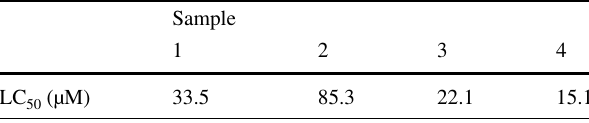
Table 1 Toxicity of compounds 1 – 4 to brine